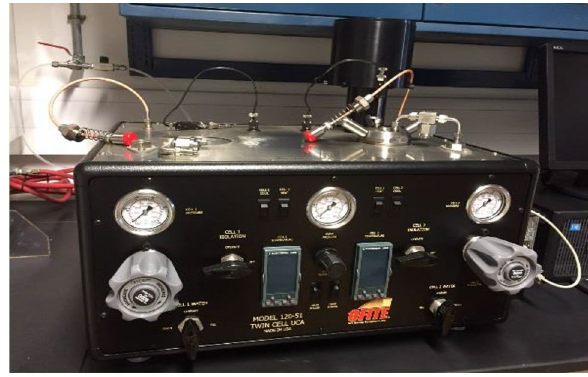
Fig. 6 OFITE ultrasonic cement analyzer, Twin Cell, 5